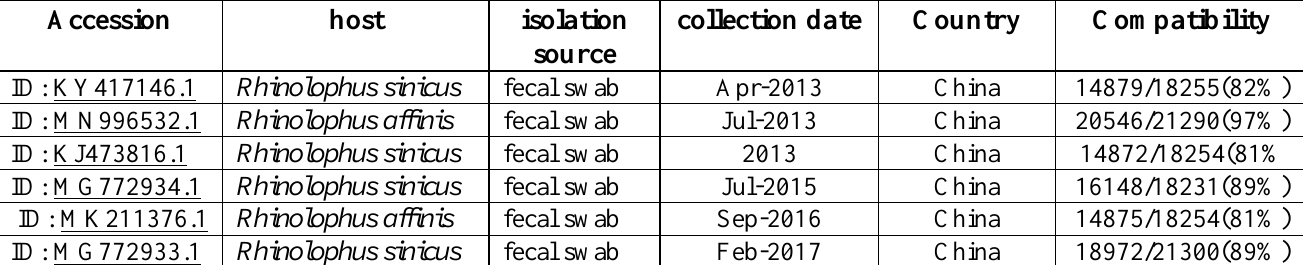
Table 2. Neighbor-joining tree of Coronavirus from bats